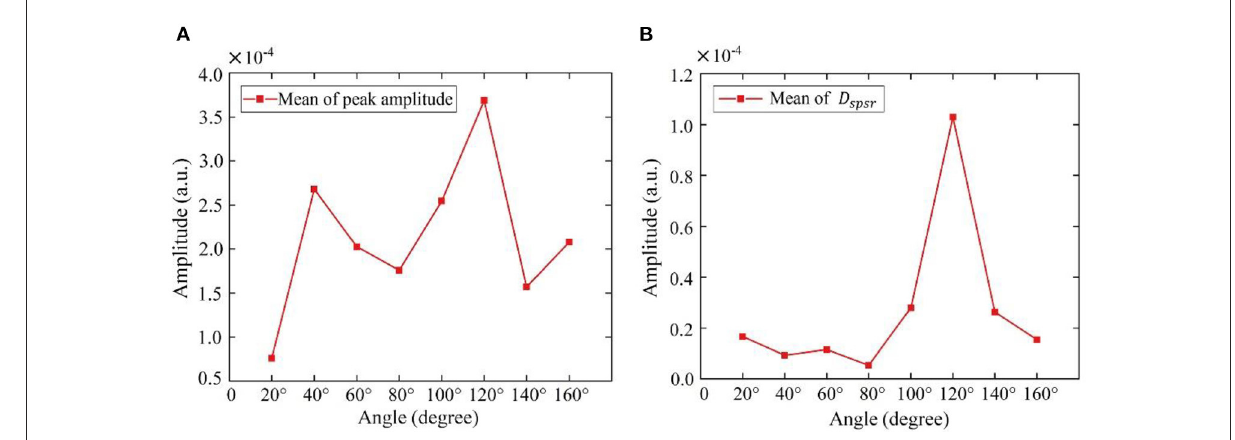
FIGURE13 Results of RCG at different angles from front side (A) overall results (mean of peak amplitude), (B) detailed results (mean of D spsr ).